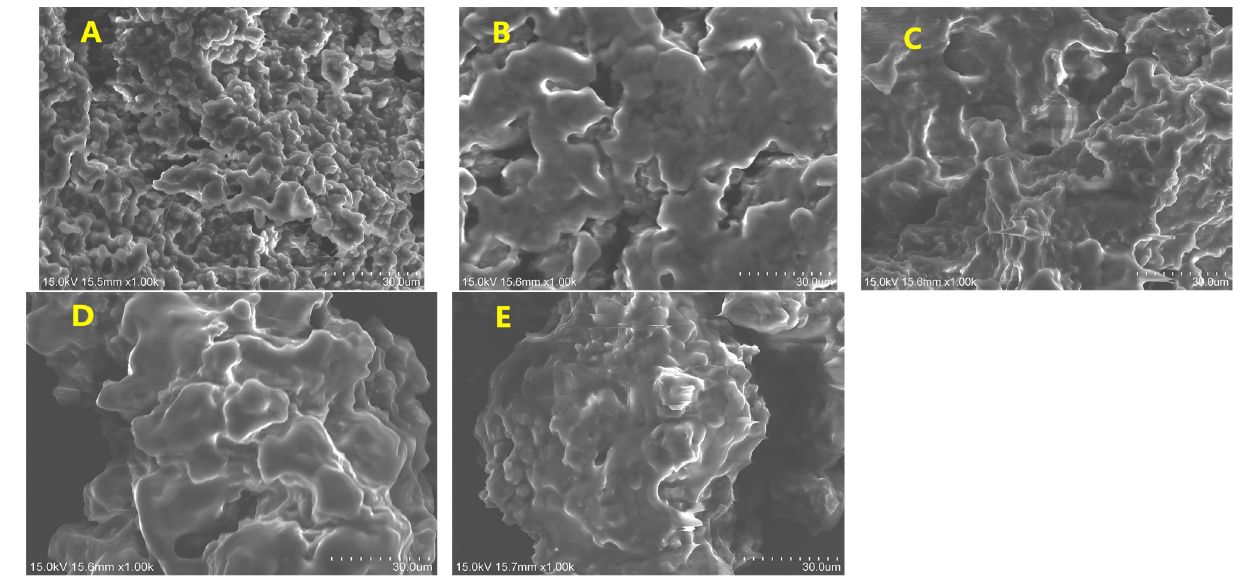
Figure 3. Scanning electron micrographs of processed cheese samples with ( A ) 0.0%, ( B ) 0.4%, ( C ) 0.8%, ( D ) 1.2%, and ( E ) 1.6% apple polyphenols. ( C ) 0.8%, ( D ) 1.2%, and ( E ) 1.6% apple